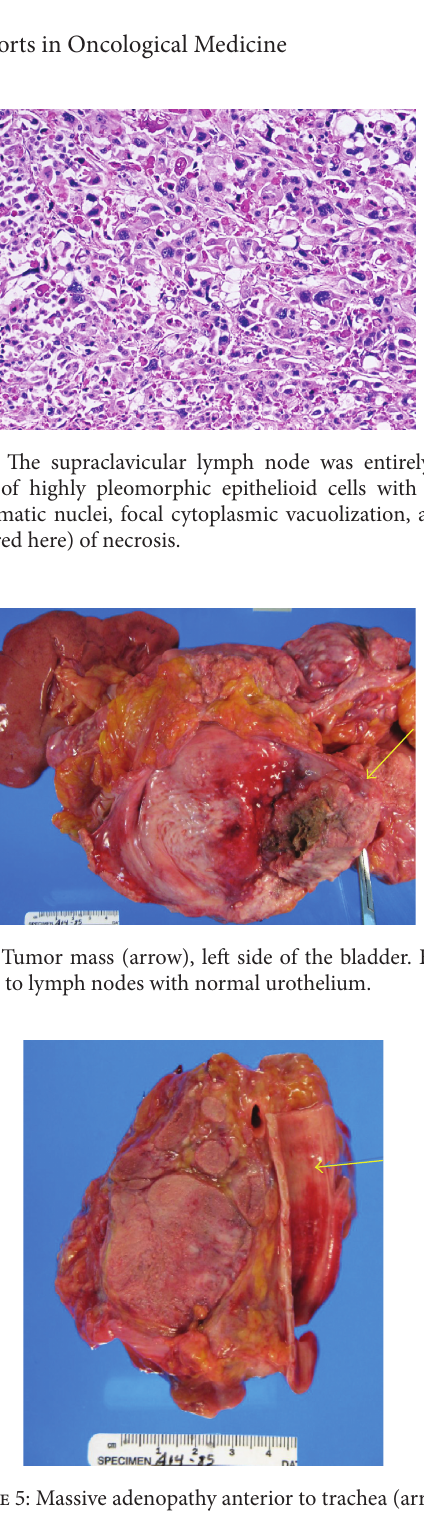
Figure 5: Massive adenopathy anterior to trachea (arrow).